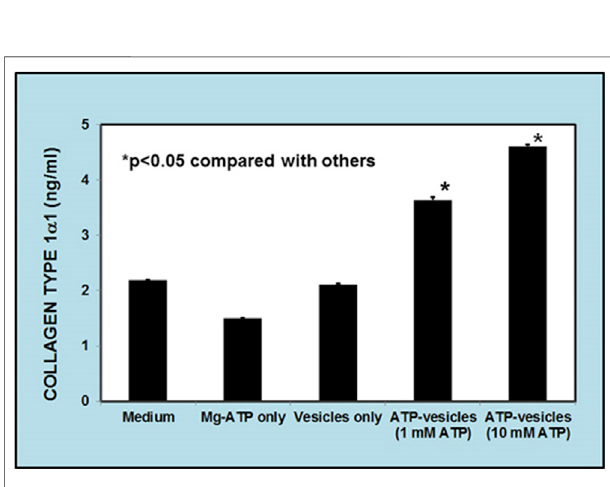
FIGURE 6 | A representative comparison of wound collagen by picrosirius red staining 7 days after surgery between the two groups. (A) . Under a regular light microscope,ATP-vesicle-treatedwoundsshowsomelargesizedandregimentedcollagen fi brils(brightred), whereasthecontrolwoundhaslessandpoorly-organized collagen. (B) . Under circular polarized microscope, the study wound shows higher type I collagen contents (stained yellow and orange) while the control wound has fewer and mostly type III collagen (stained green). Scale bar is 50 μ m.